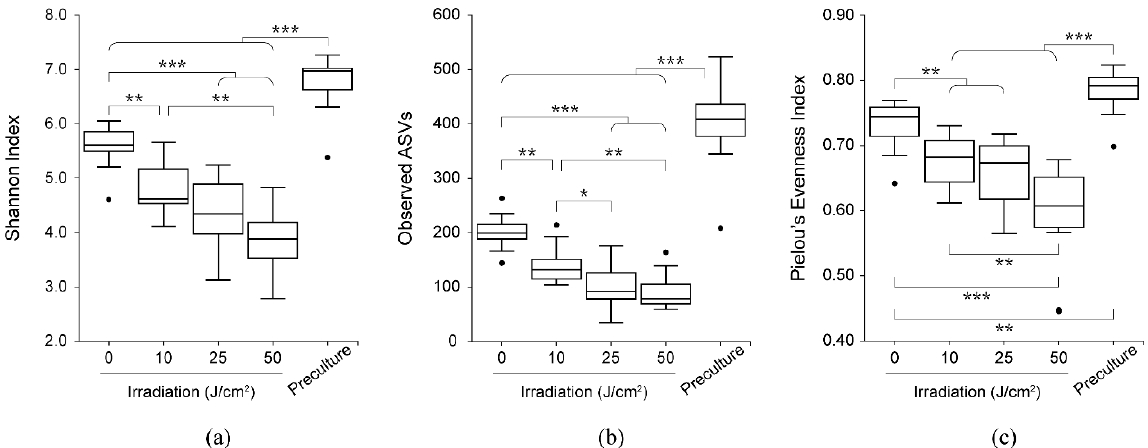
Figure 3. Comparisons of alpha diversity of precultured and irradiated samples at each dose. Boxplots of alpha diversity indices are displayed by ( a ) Shannon index, ( b ) observed ASVs, and ( c ) Pielou’s evenness index (* p < 0.05, ** p < 0.01, *** p < 0.001, Kruskal–Wallis test).